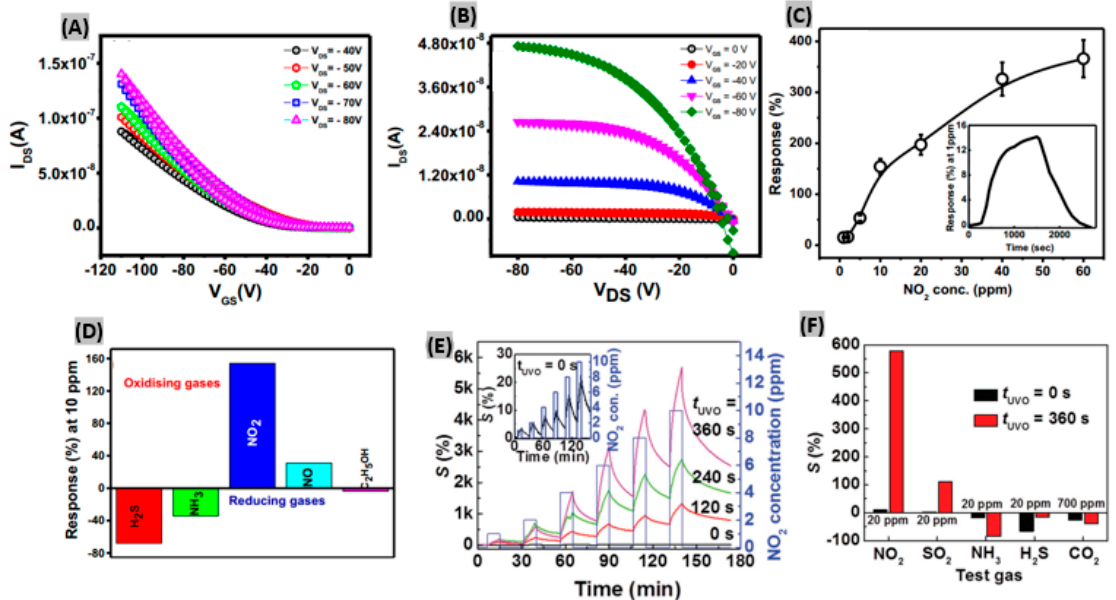
Figure 5. ( A ) Transfer ( B ) Output characteristics of the PCDTBT based OFET. ( C ) Sensor response at different NO 2 concentrations. Response-recovery of the sensor at 1 ppm of NO 2 (inset). (D) Selectivity